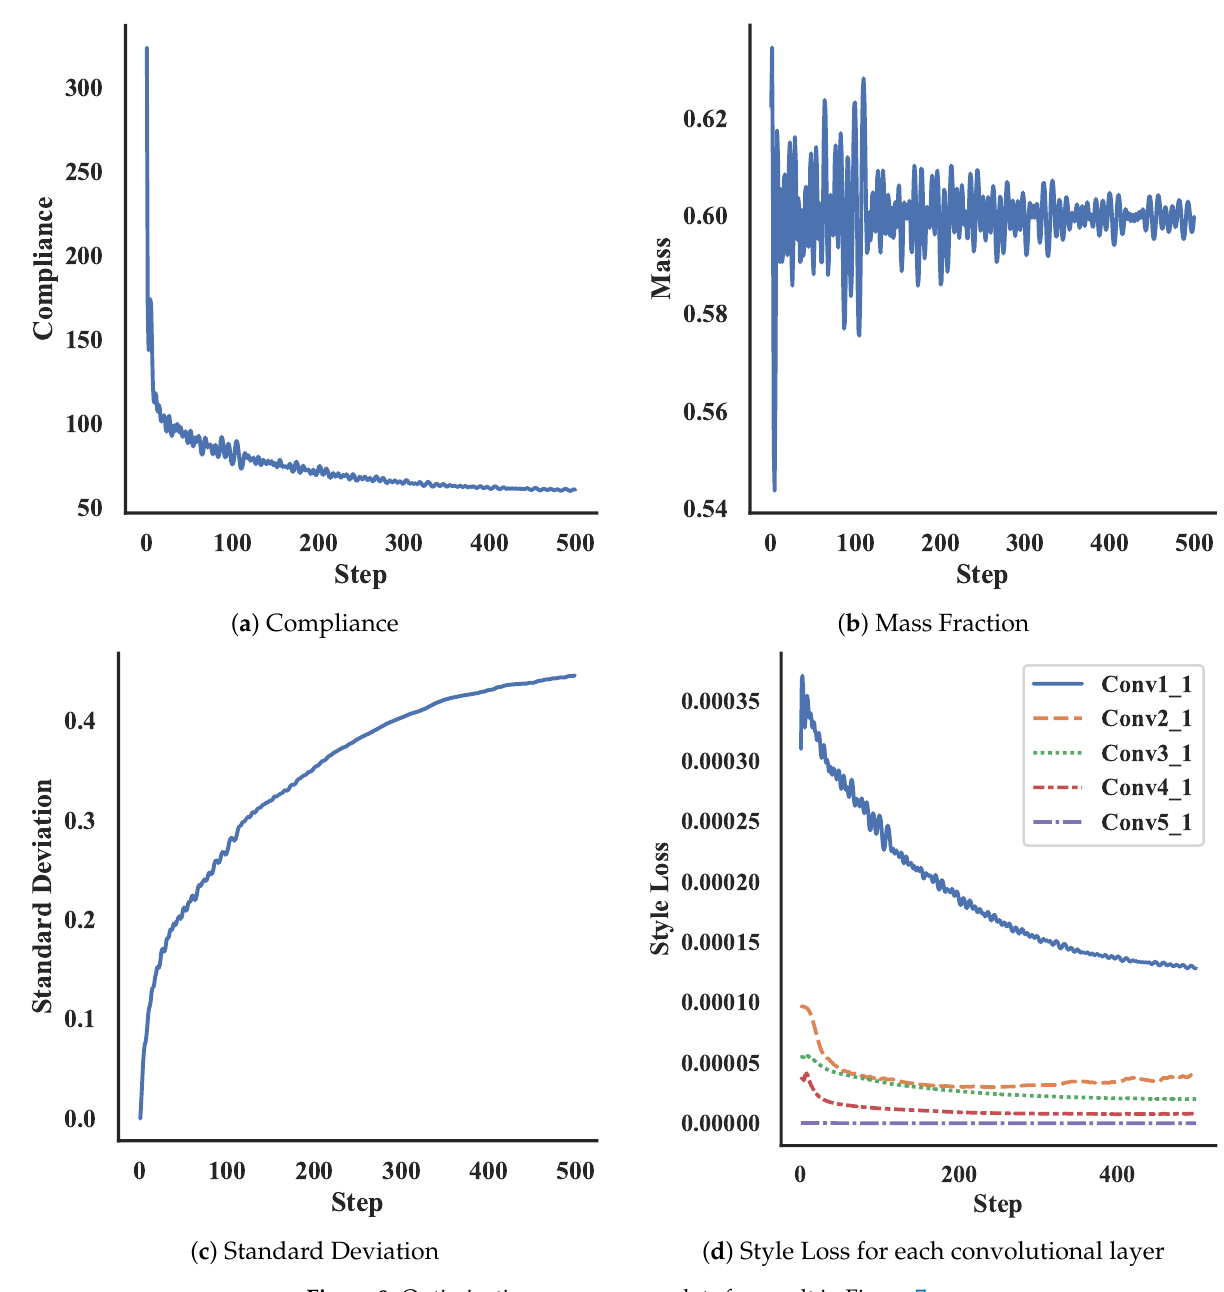
Figure 9. Optimization convergence plots for result in Figure 7c. Table 2. Average Time per Iteration of